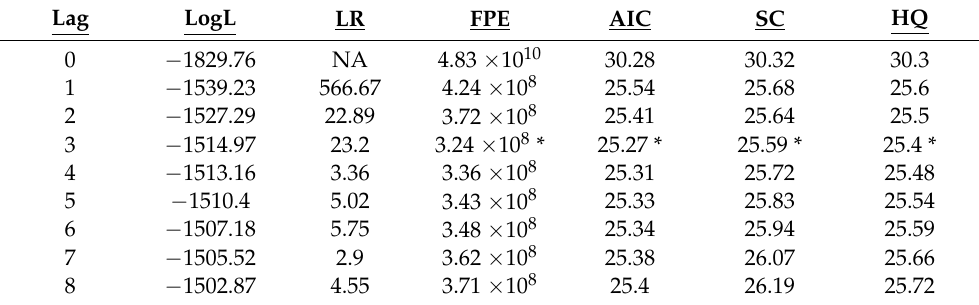
Table A1. VAR lag order selection criteria. Endogenous variables: oil price and trade balance. Lag